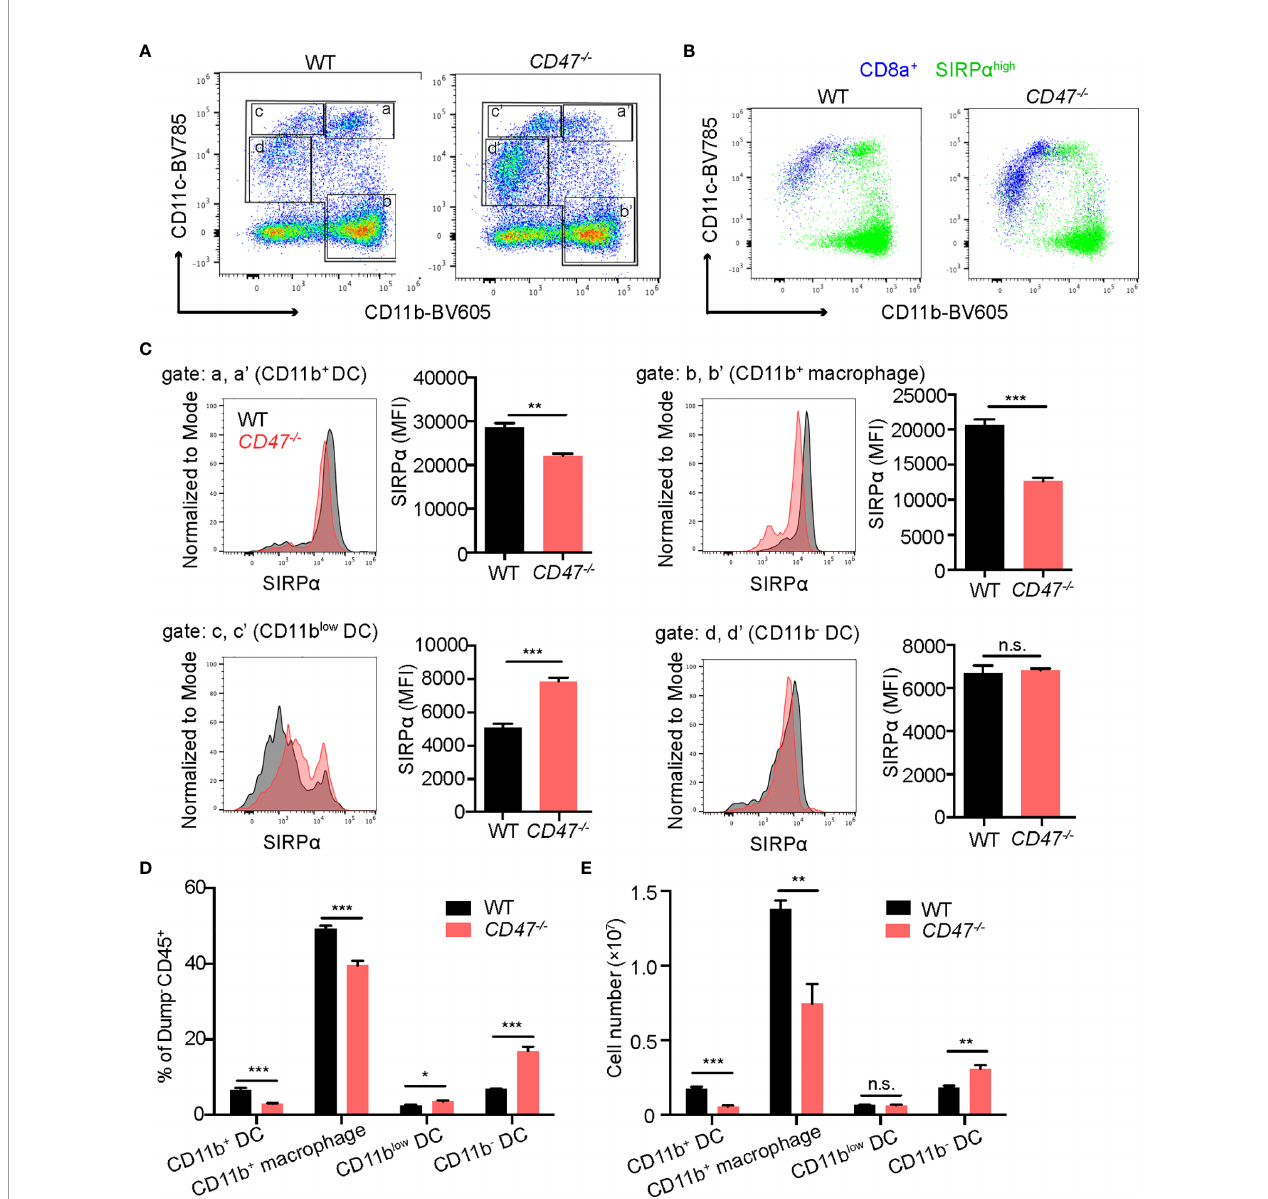
FIGURE 5 | SIRP a expression in CD11b + macrophages/DCs is decreased in CD47 de fi cient mice with autoimmune uveitis. WT and CD47 -/- mice were immunized and spleen cells were collected 14 days post immunization and examined by fl ow cytometry. (A) Live cells (Zombie UV - ) excluding a dump gate (T cells; CD3, B cells; CD19, NK cells; NK1.1, and granulocytes; Ly6G) were gated on CD45 + cells and further separated by CD11b and CD11c. The gates were de fi ned as follows: Gates a and a ’ ; CD11b + CD11c high (CD11b + DCs), gates b and b ’ ; CD11b + CD11c - (macrophages), gates c and c ’ ; CD11b low CD11c + (CD11b low DCs), and gates d and d ’ ; CD11b - CD11c low (CD11b - DCs). (B) SIRP a high cells and CD8a + cells in (A) are shown in green and blue, respectively. (C) SIRP a expression on each macrophage and DC population gated in (A) was examined. (D) Frequency of each macrophage/DC population in spleens was determined by using frequency of each population in ZombieUV - dump - CD45 + cells. (E) Cell number of each macrophage/DC population was obtained by using the number of cells in each SP and the frequency of each population in ZombieUV - cells. Data were analyzed by Student ’ s t test and expressed as mean ± SEM. *P<0.05; **P<0.01; ***P<0.001. n.s., not signi fi cant. n=4 mice per